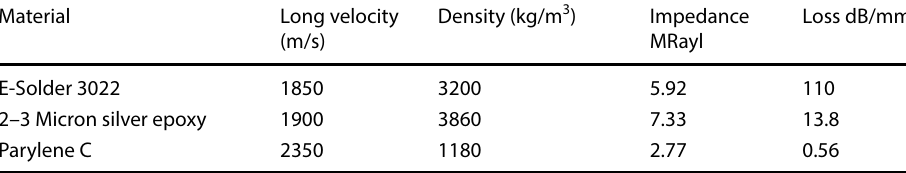
Values extracted from